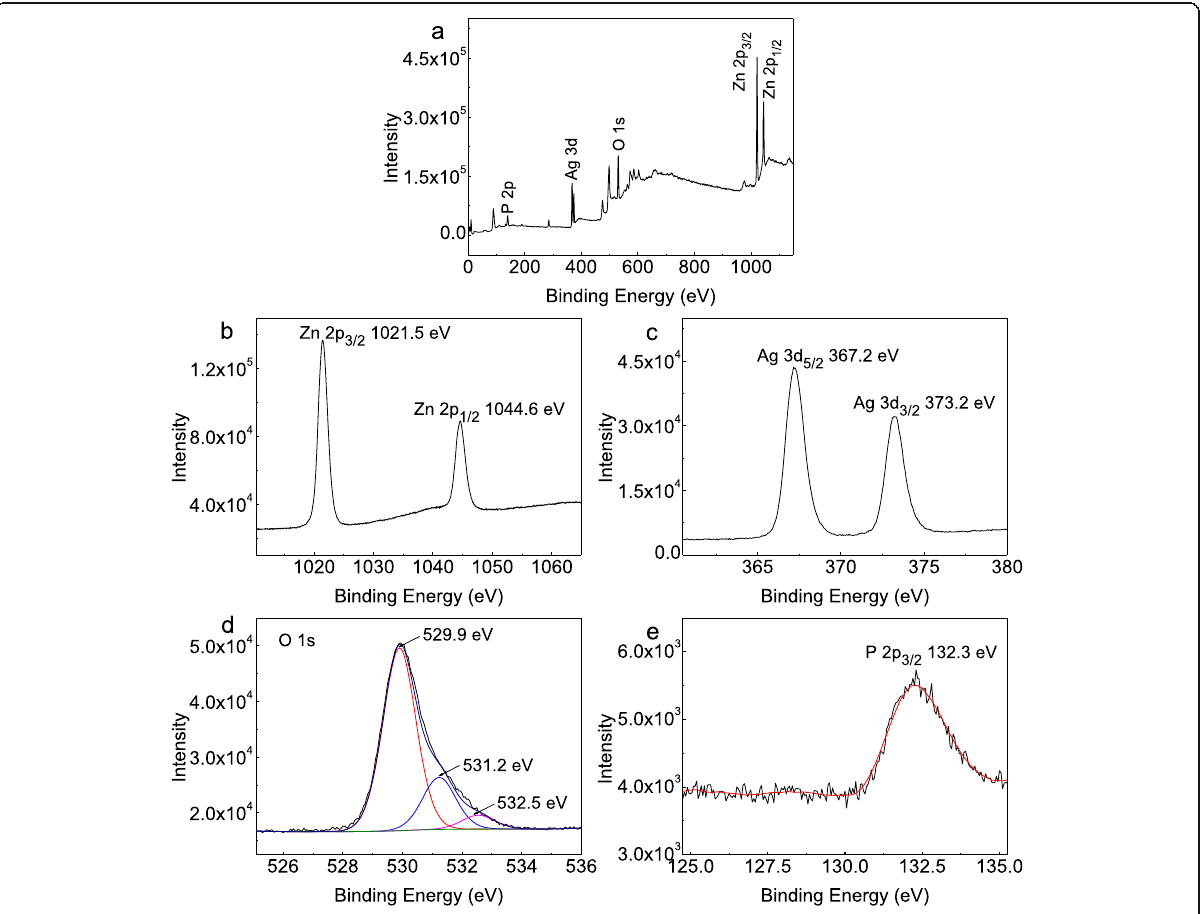
Fig. 3 XPS spectra of Ag 3 PO 4 /T-ZnOw-2: a survey scan, b Zn 2p, c Ag 3d, d O1s, and e P 2p